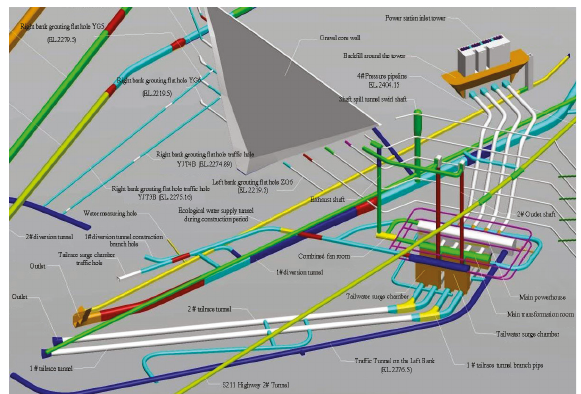
Figure 1: Layout of the buildings for diversion and power gen- eration on the left bank.